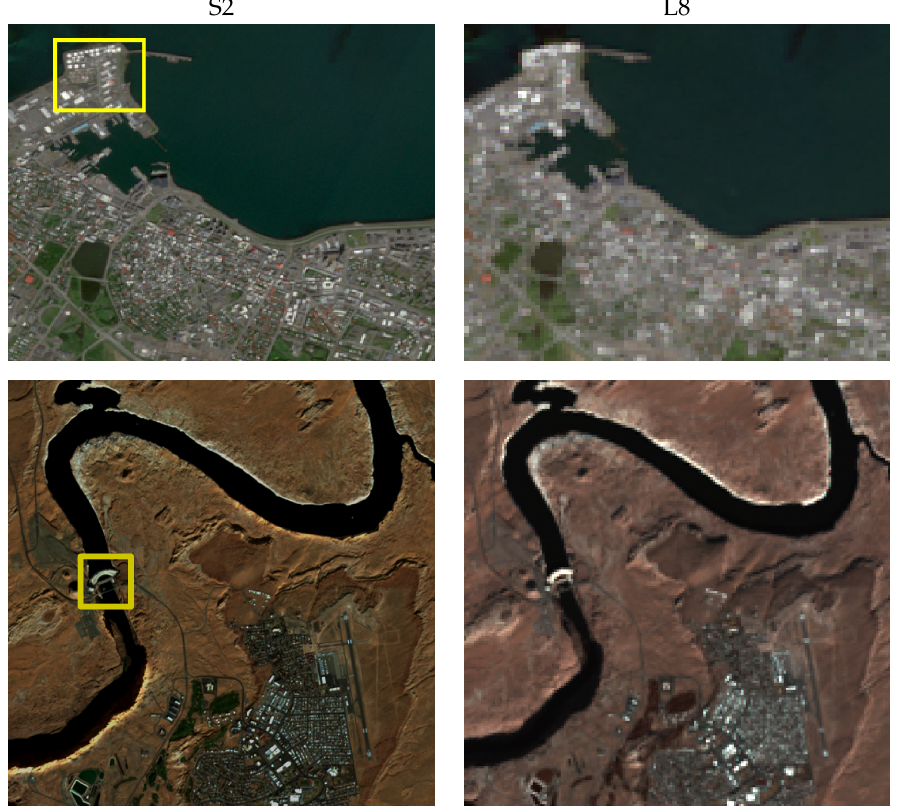
Figure 3. The RGB images of Reykjavik ( upper ) and Glen Canyon ( lower ), which were generated using bands 2–4 of the S2 ( left ) and L8 ( right )